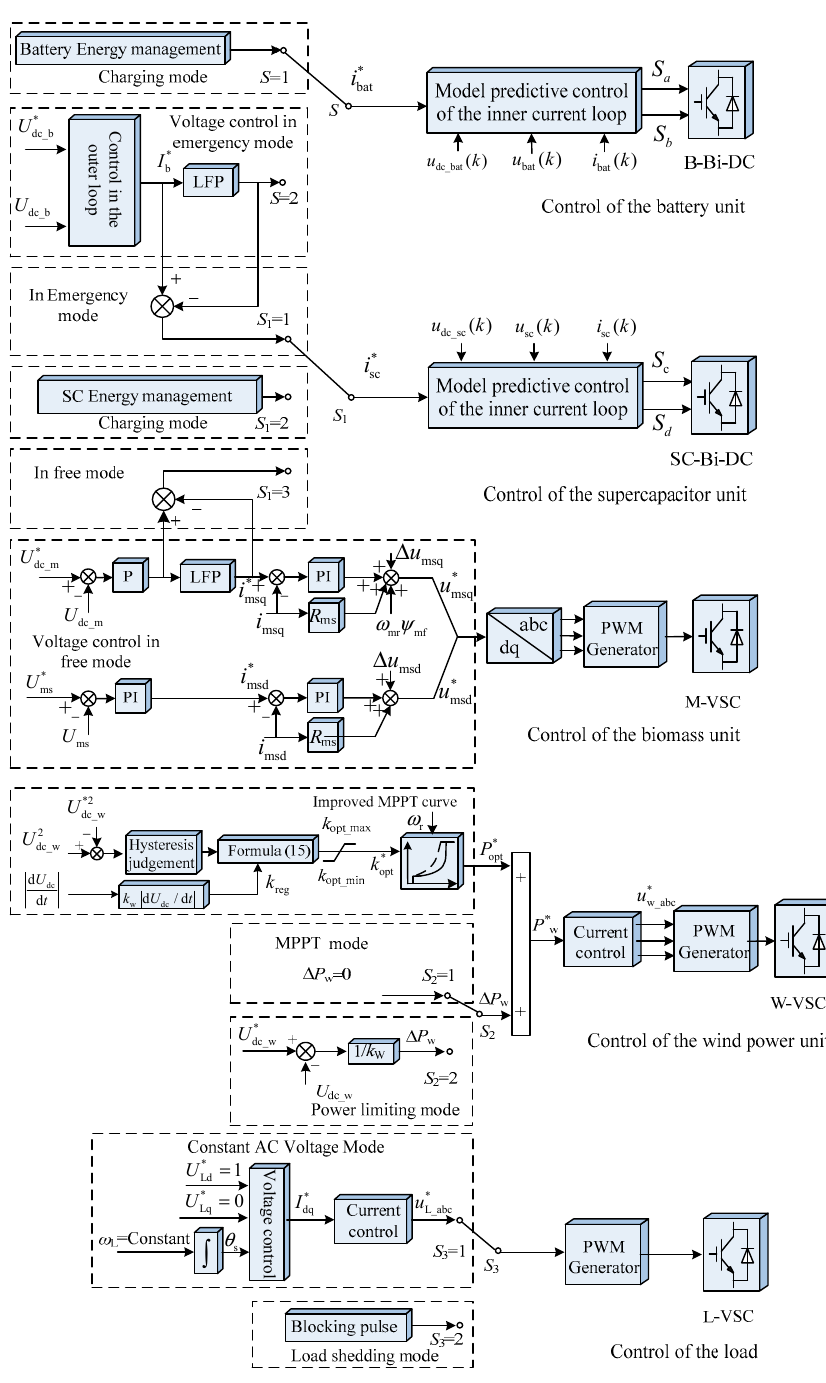
Figure 12. Overall control of the islanded DC microgrid in a forest area.